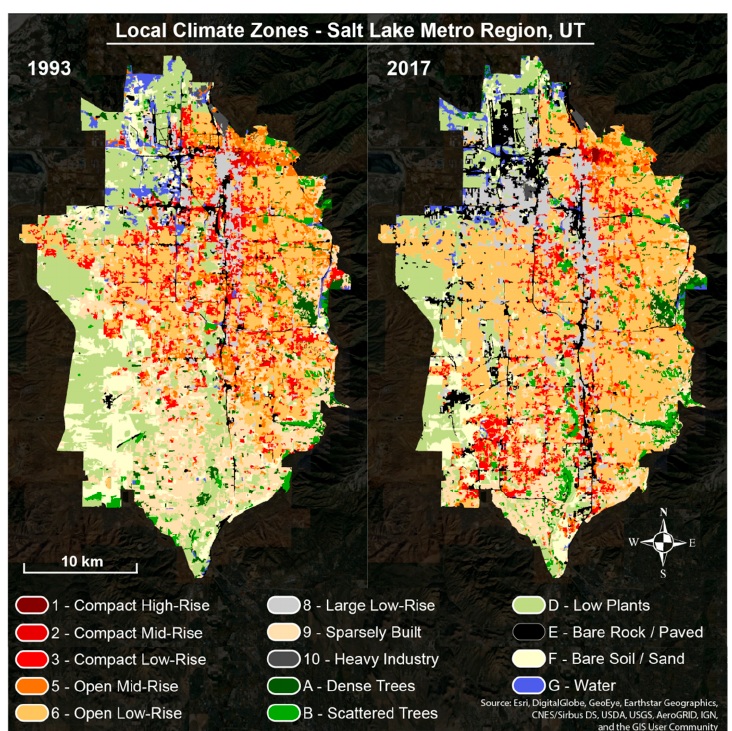
Figure 4. Local climate zone distributions mapped via Random Forest algorithm for 1993 and 2017.